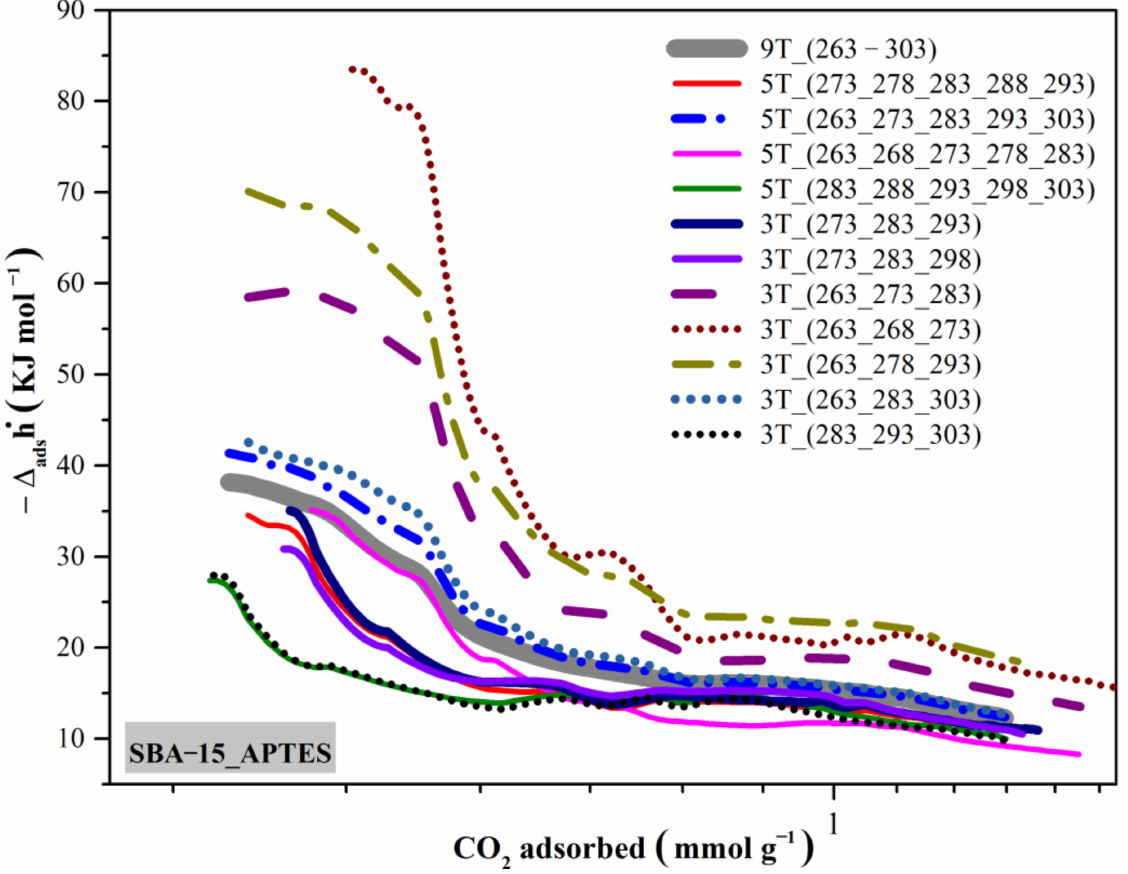
Figure 12. CO 2 isosteric enthalpy of SBA-15 calcinated at 623 K and functionalized with APTES. The three materials were compared, considering the CO 2 isotherms and the ∆ ads